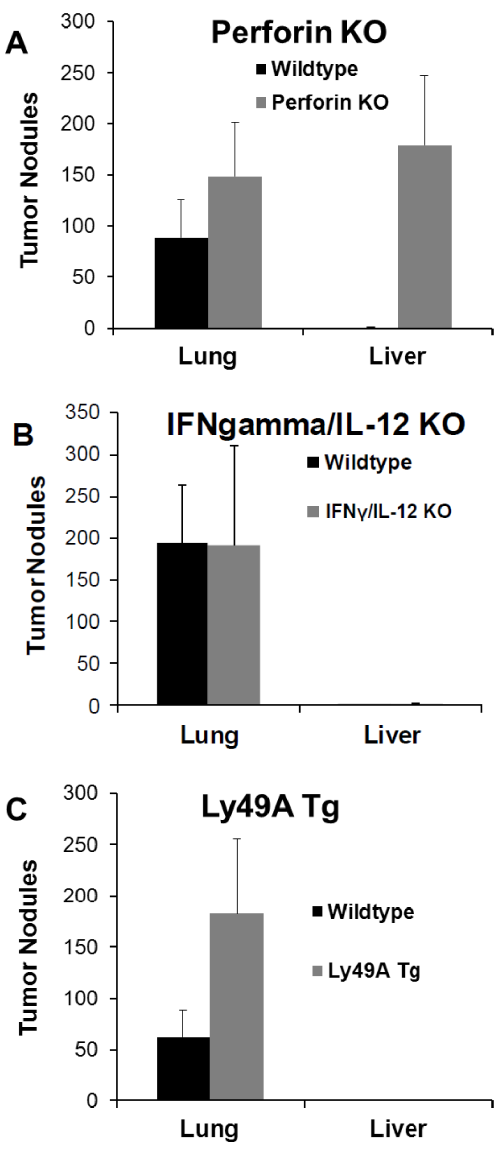
Figure 2. Intravenous inoculation with B16F1 melanoma results in the establishment of liver tumor nodules in NK cell deficient mice. 2 6 10 5 melanoma cells were injected i.v. into (A) wild- type, (B) SCID or (C) c c/RAG 2 KO mice (all on a C57BL/6 background). Twelve days later, lungs and livers were excised and tumors enumerated. There were five mice per group.